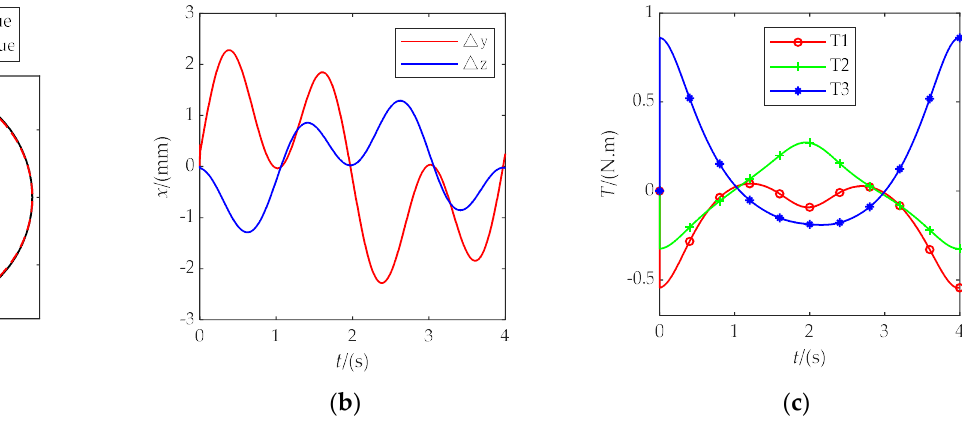
Figure 10. ( a ) Simulation result of circular trajectory ; ( b ) the error curve of the trajectory; ( c ) the curve of the motor-driving torque.